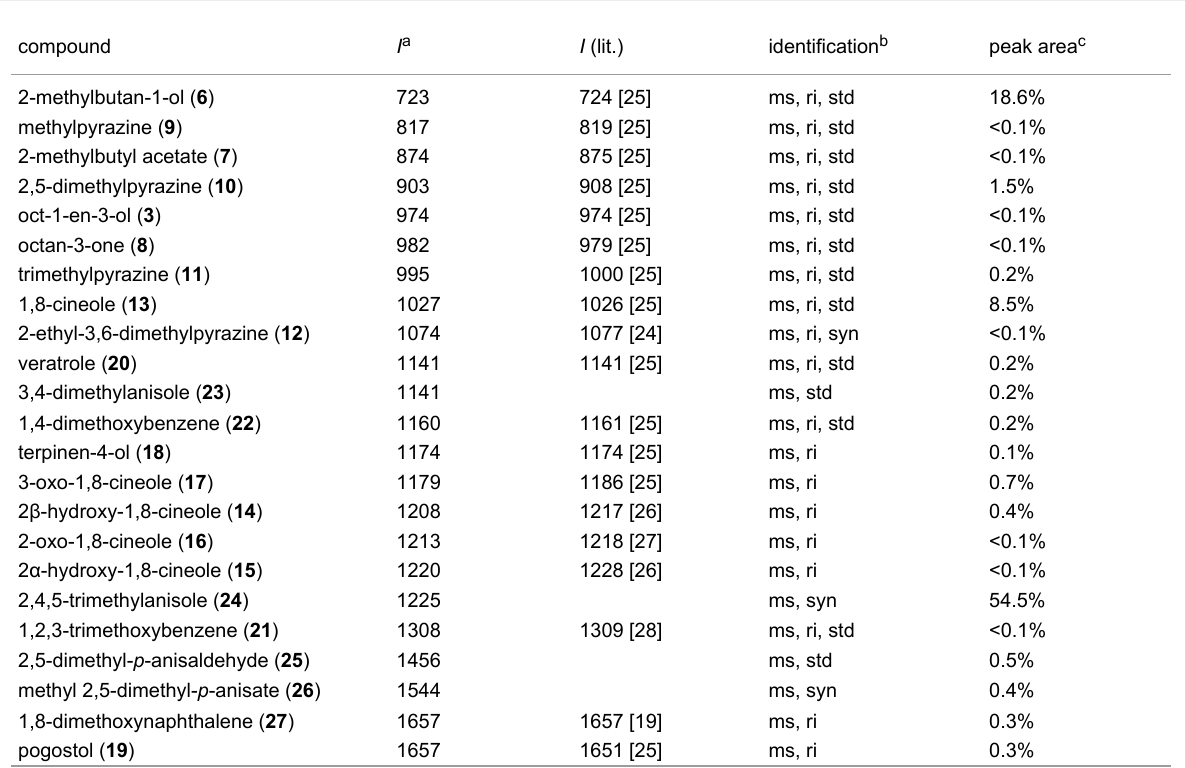
Table 1: Volatiles identified in the headspace extract from Hypoxylon griseobrunneum MUCL